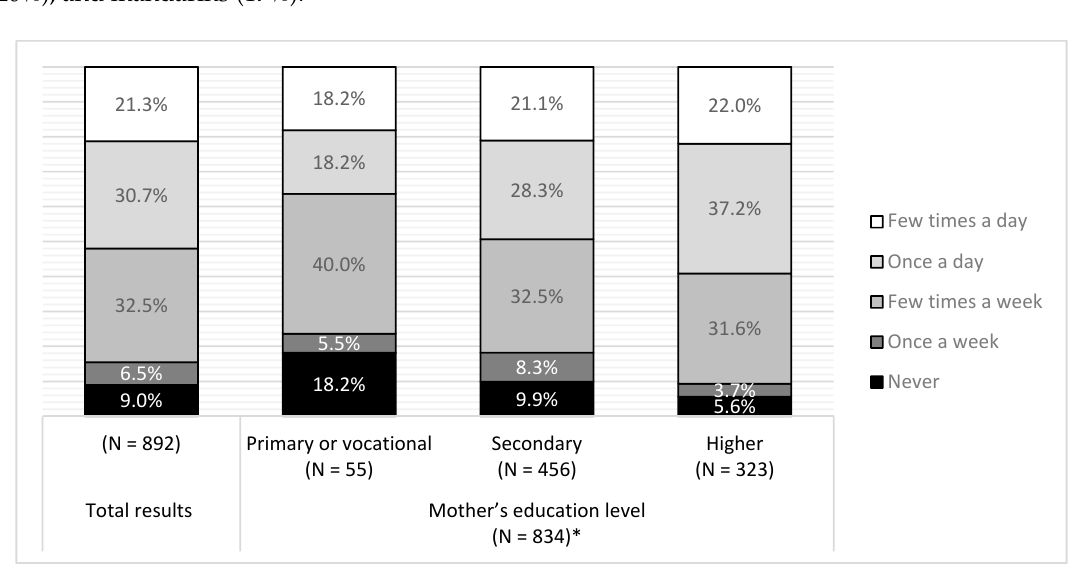
Figure 2. Frequency of vegetable consumption in the total surveyed population and sub-groups according to mother’s education level. * 58 mothers did not declare education level.